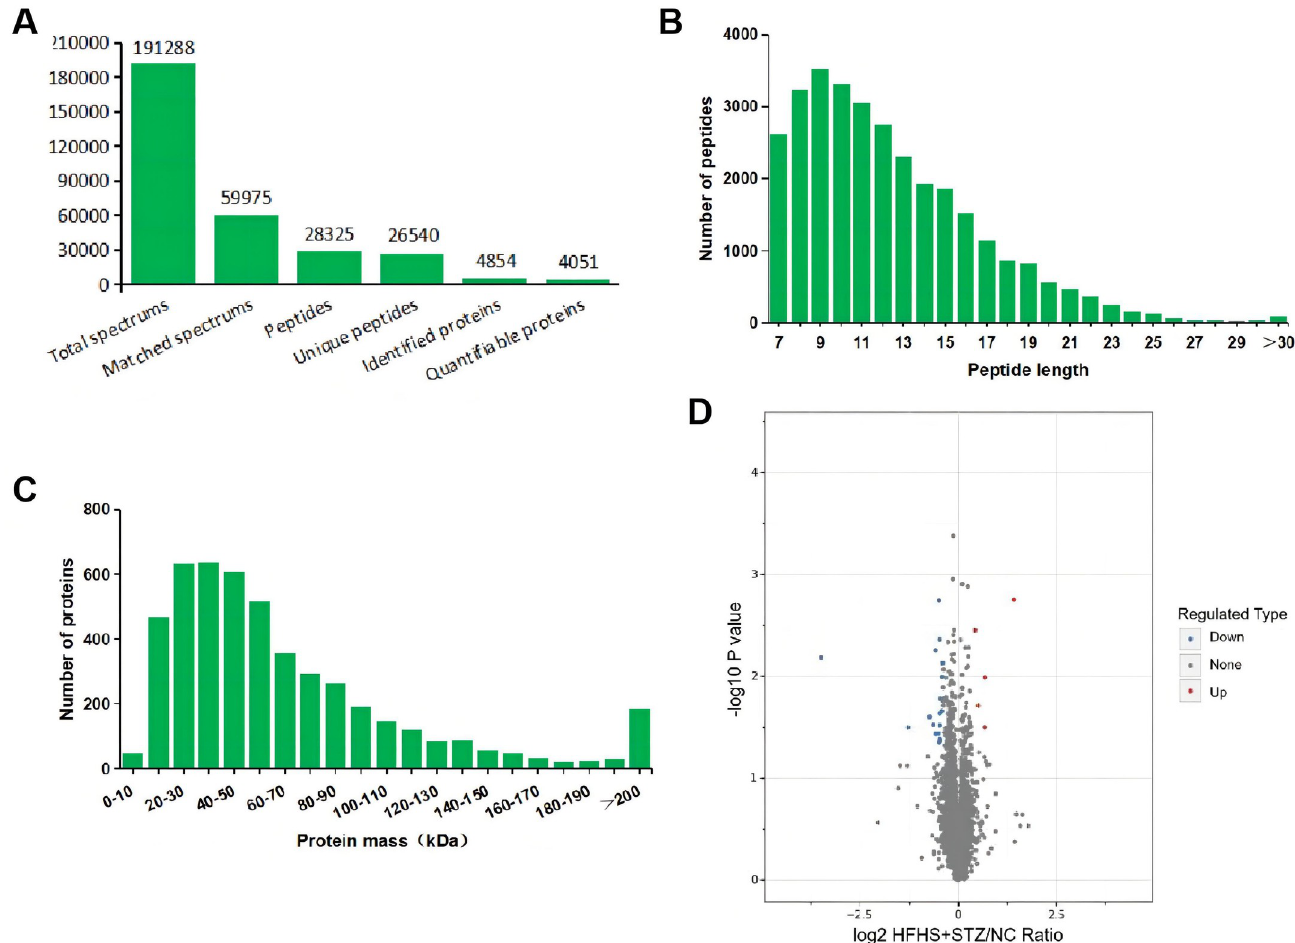
Fig 7. Overview of differentially expressed proteins and peptides. (A) Basic statistics of mass spectral data, (B) Peptide length, (C) Protein mass, and (D) Volcano plot of differentially expressed placental proteins between the HFHS+STZ and NC groups.